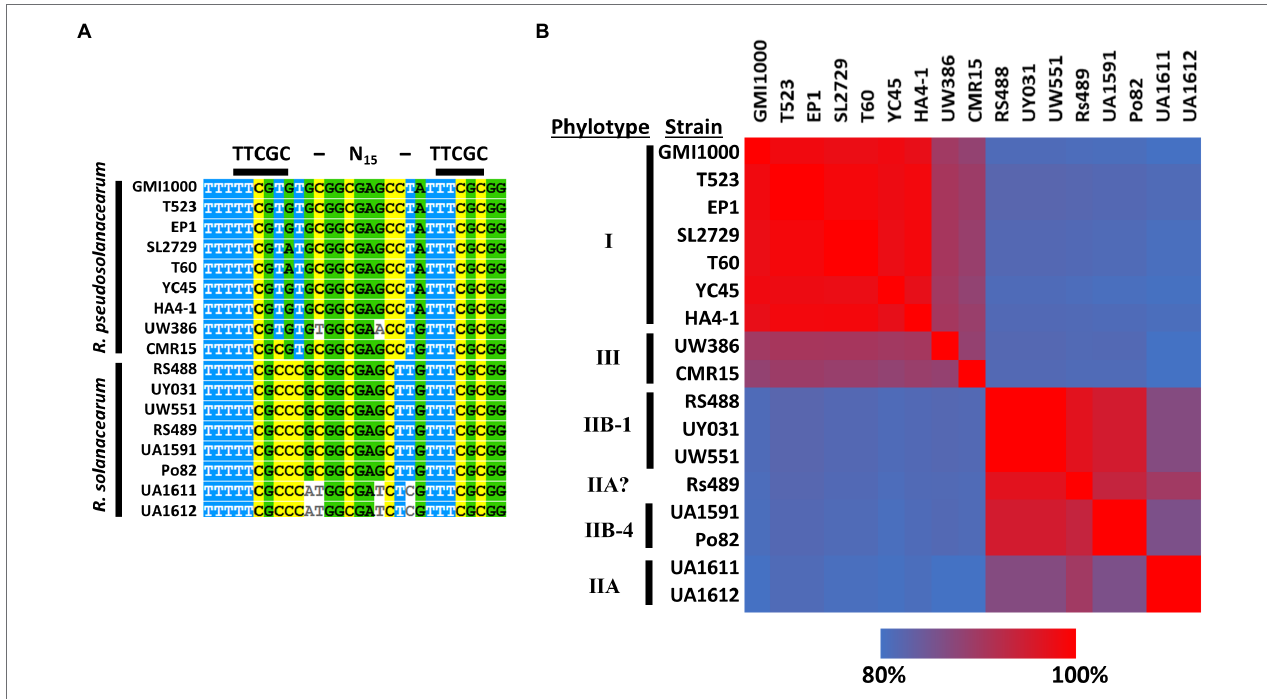
FIGURE 4 | Multiple sequence alignment of PIP-box located about 600 bases upstream of RipS1 in various Ralstonia solanacearum species complex (Rssc) strains shows that phylotype II strains harbor a perfect PIP-box consensus match at this site (A) . Heatmap showing percent identity for the intergenic region between RRSL_04180 and ripS1 in various R. solanacearum species complex strains indicates that phylotype II strains clearly separate from phylotypes I and III in this region and IIB-1 strains can be separated from all other strains (B) . Multiple sequence alignments were generated and percent identity calculated using